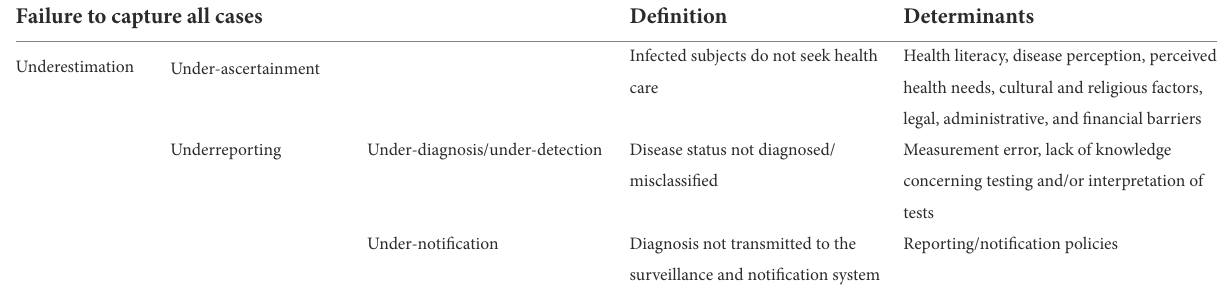
TABLE 2 Underestimation, its components/dimensions with definitions and